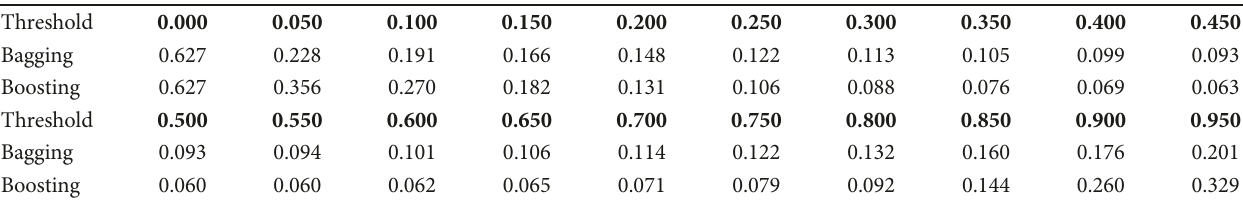
Table 6: Total error of the models used.